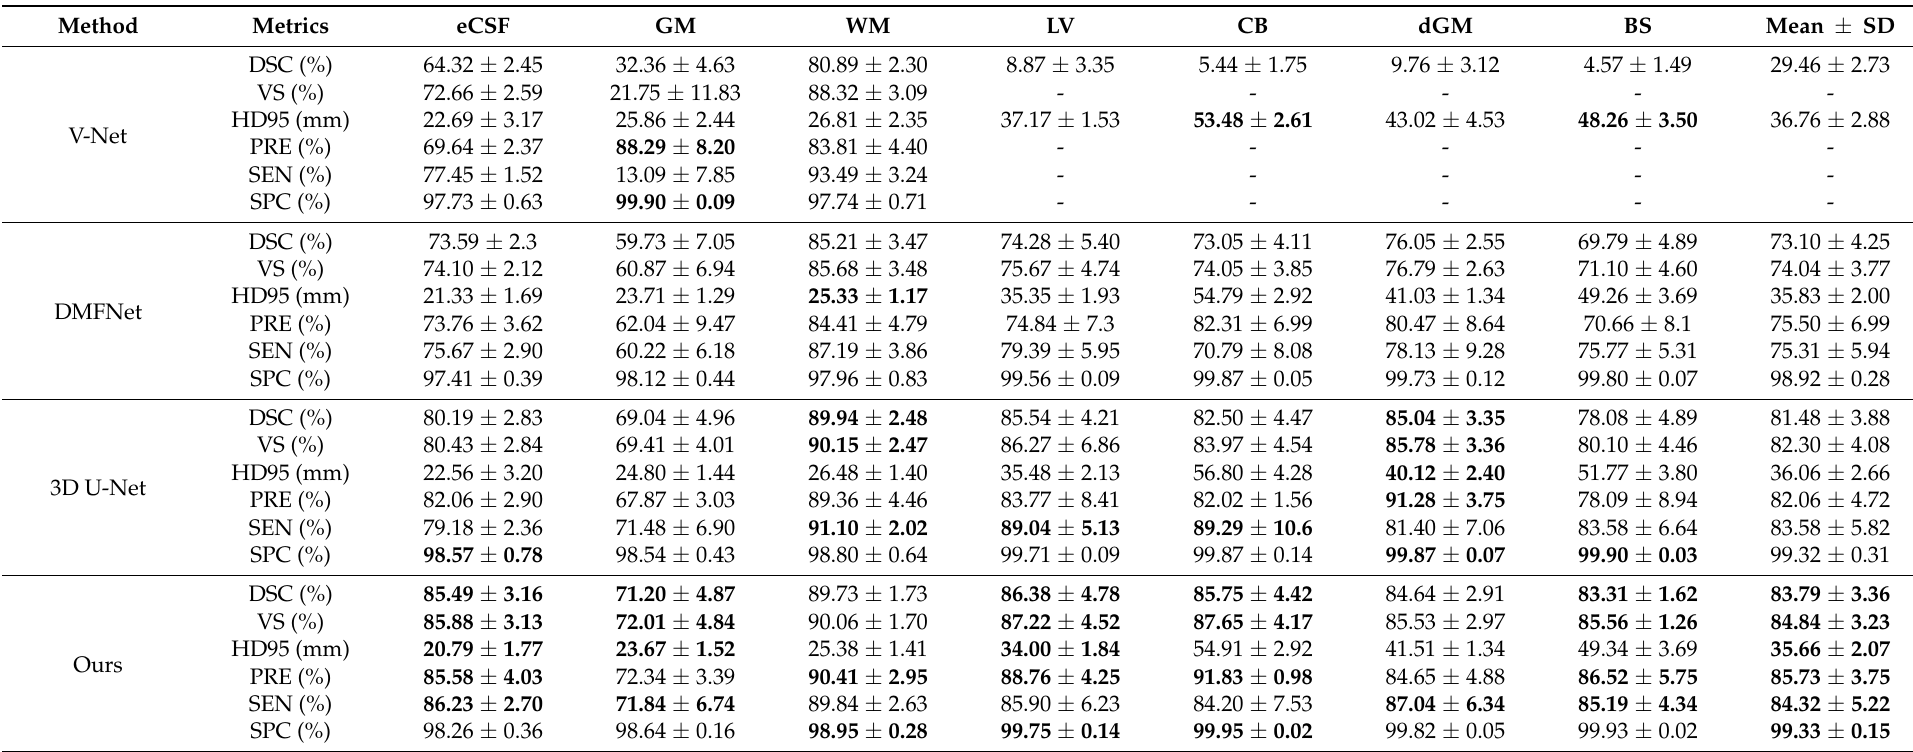
Table 1. Comparison of segmentation results of different methods (V-Net, DMFNet, 3DU-Net and Ours) on different tissues based on quantitative performance metrics (DSC, VS, HD95, PRE, SEN, SPC). The best value for each metric in each tissue is marked in